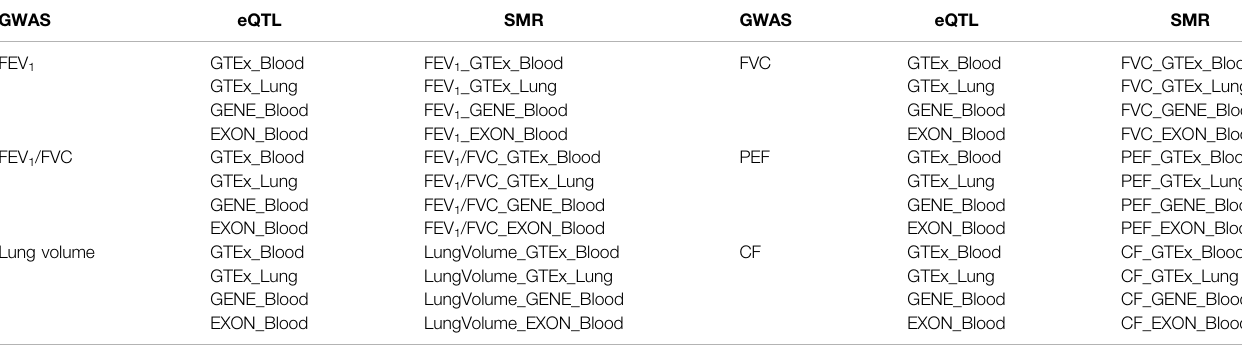
TABLE 1 | The new dataset list for SMR analysis. Thirty SMR datasets were created for this analysis. GWAS eQTL SMR